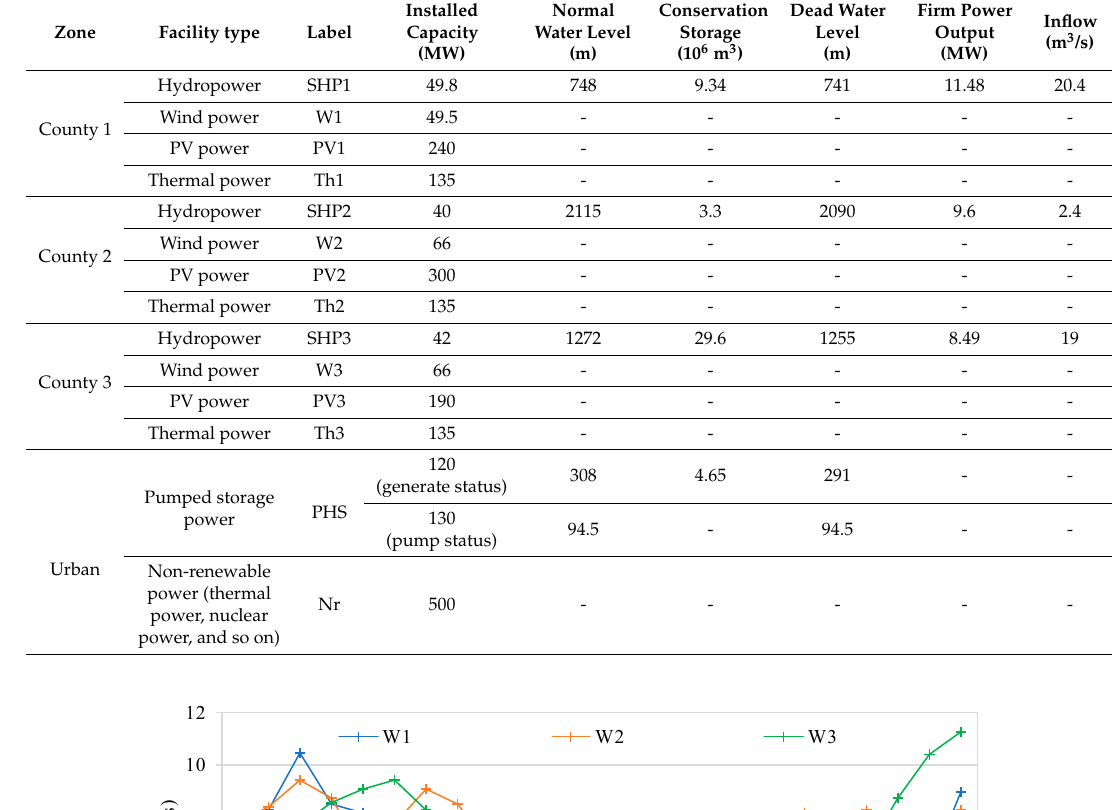
Table A1. Parameters of the power stations.